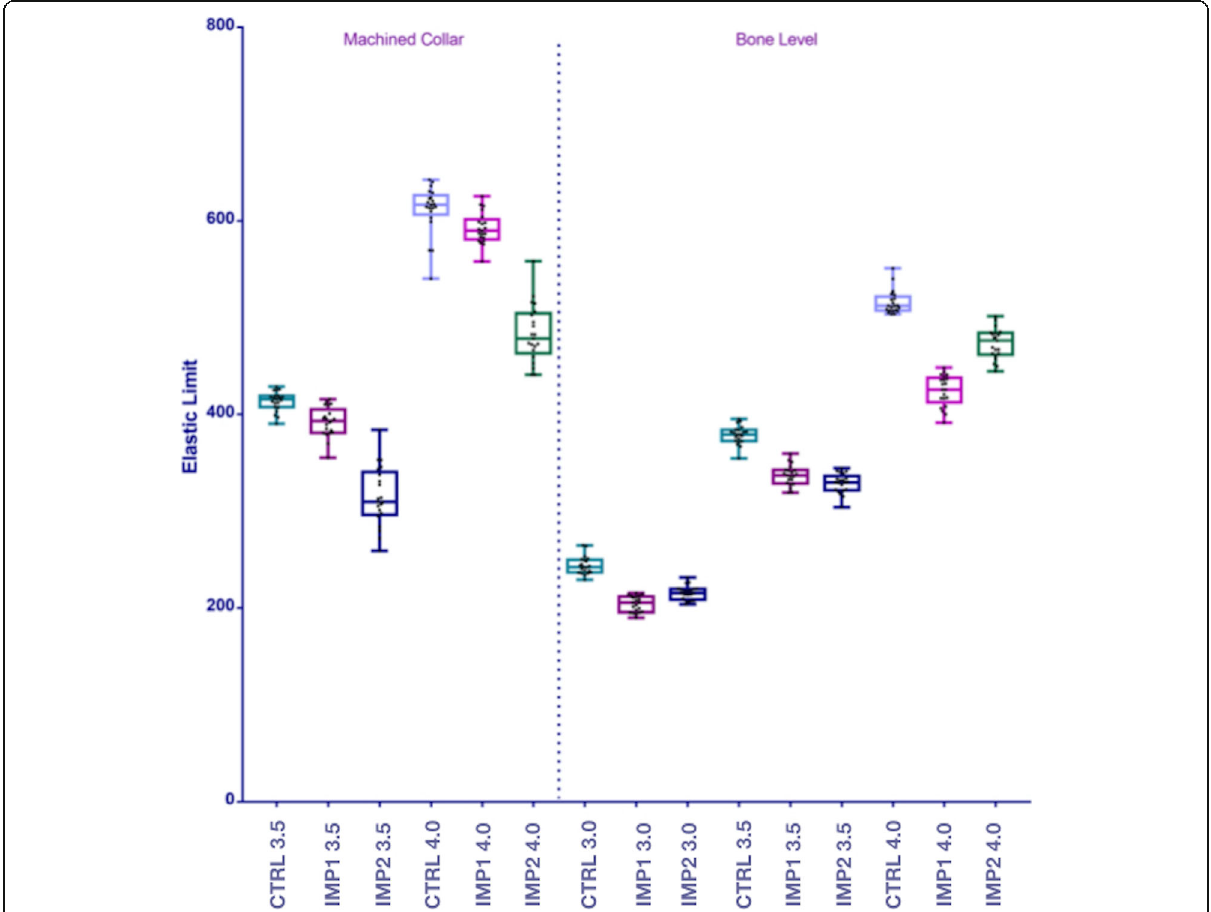
Fig. 4 Boxplot graphs showing the elastic limit values for the machined collar (tissue-level) and the bone-level implant groups after the loading test